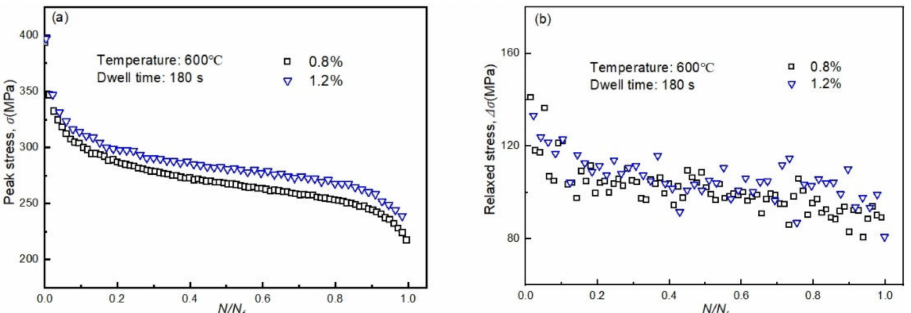
Figure 7. The evolution of, ( a ) peak stress and ( b ) relaxed stress showing the influence of strain range with 180 s dwell time at 600 ◦